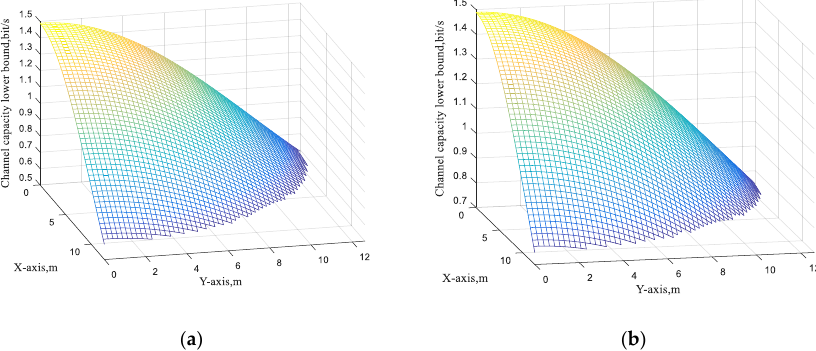
Figure 4. ( a ) Lower bound of the capacity with respect to the coordinates of the receiver without tilting the receiver plane; ( b ) Lower bound of the capacity with respect to the coordinates of the receiver with an optimally tilted receiver plane.